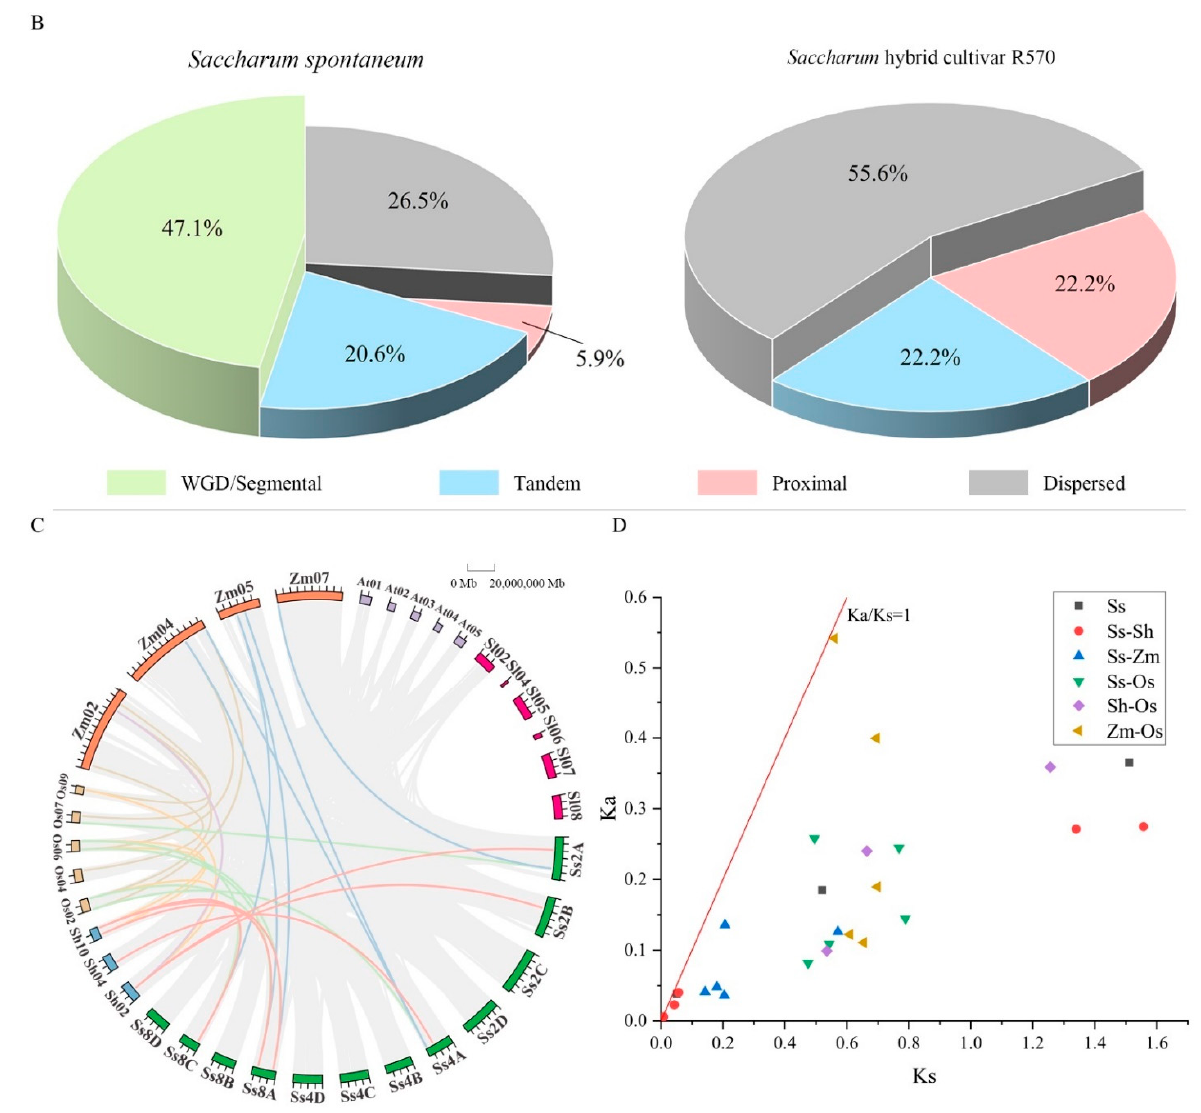
Figure 5. Evolutionary analysis of SsGLRs and ShGLRs . ( A ) Chromosome localization of SsGLRs and ShGLRs ; each green bar represented chromosome, the left side showed its own chromosome number, and the red line represented the collinear relationship within the species. ( B ) Distribution of gene replication types of SsGLRs and ShGLRs . WGD represented whole-genome duplications. ( C ) Synteny analysis among six species. The pink line represented homologous GLR gene pairs between S. spontaneum and S. hybrid R570; the green line represented homologous GLR gene pairs between S. spontaneum and O. sativa; the blue line represented homologous GLR gene pairs be- tween S. spontaneum and Z. mays ; the orange line represented homologous GLR gene pairs between S. hybrid R570 and O. sativa ; the purple line represented homologous GLR gene pairs between S. hybrid R570 and Z. mays ; the brown line represented homologous GLR gene pairs between O. sativa and Z. mays . The 0 to 20,000,000 Mb refers to the size of each scale on the chromosome. ( D ) Homologous relationship between species. Y axis and X axis represented synonymous mutation (Ka) and non-synonymous mutation (Ks) values of each pair, and the red line showed Ka/Ks =1; the details of Ka, Ks, and Ka/Ks are listed in Table S12. Chromosome names were named by species abbreviations of A. thaliana (At), S. lycopersicum (Sl), O. sativa (Os), Z. mays (Zm), S. spontaneum (Ss), and S. hybrid R570